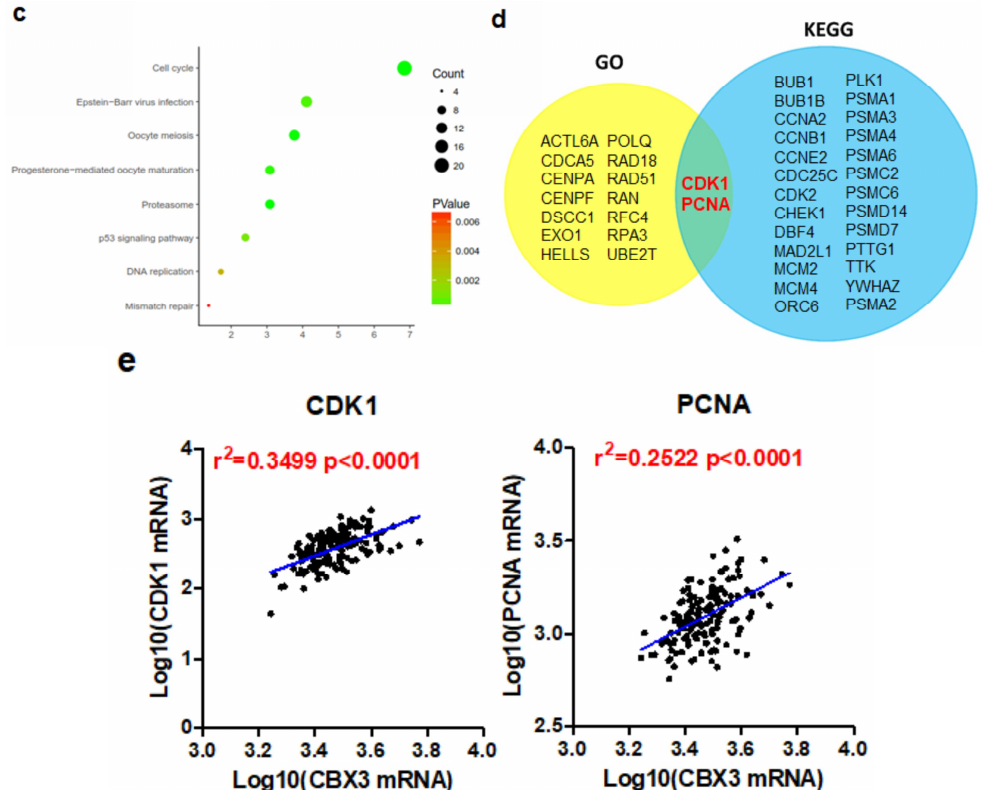
Figure 4. CBX3 may regulate the cell cycle transition of PAAD cells. ( a ) Correlated genes were retrieved from TCGA data and processed with GO annotation. Biological process (BP), Molecular function (MF) and cell component (CC) of the correlated genes were predicted. It was shown that CBX3-correlated genes were mostly related to cell cycle regulation and DNA replication. Items tagged with red asterisk were related to DNA replication and cell cycle regulation; ( b ) Common genes among cell cycle regulations from BP, MF and CC annotation was extracted by Venn diagram. Sixteen genes were shared in common; ( c ) KEGG pathway analysis with CBX3-correlated genes. It was consistently shown that cell cycle regulation may be involved; ( d ) Common genes between GO annotation and KEGG analysis revealed that CDK1 and PCNA may be the core element in the regulation of cell cycle by CBX3; ( e ) Expression of CBX3, CDK1 and PCNA in PAAD tissue was extracted, and correlation was analyzed by linear regression. It was shown that CDK1 and PCNA expression in PAAD tissue was positively correlated to CBX3